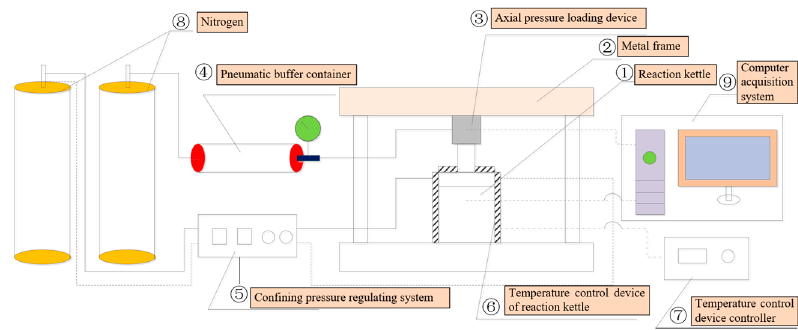
Figure 7. Schematic diagram of device